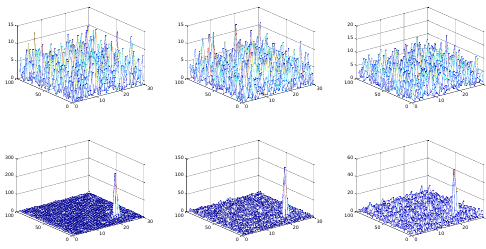
Figure8. 3D view of lightning signals Figure 9 has shown the energy spectrum or DN value of some pixel point during the night. Figure 10 has shown the energy spectrum or DN value of some pixel point during the daytime. The data length is 24800 frames, about 1min, which was got from the on-orbit data. The red points in figures are the detected signals.